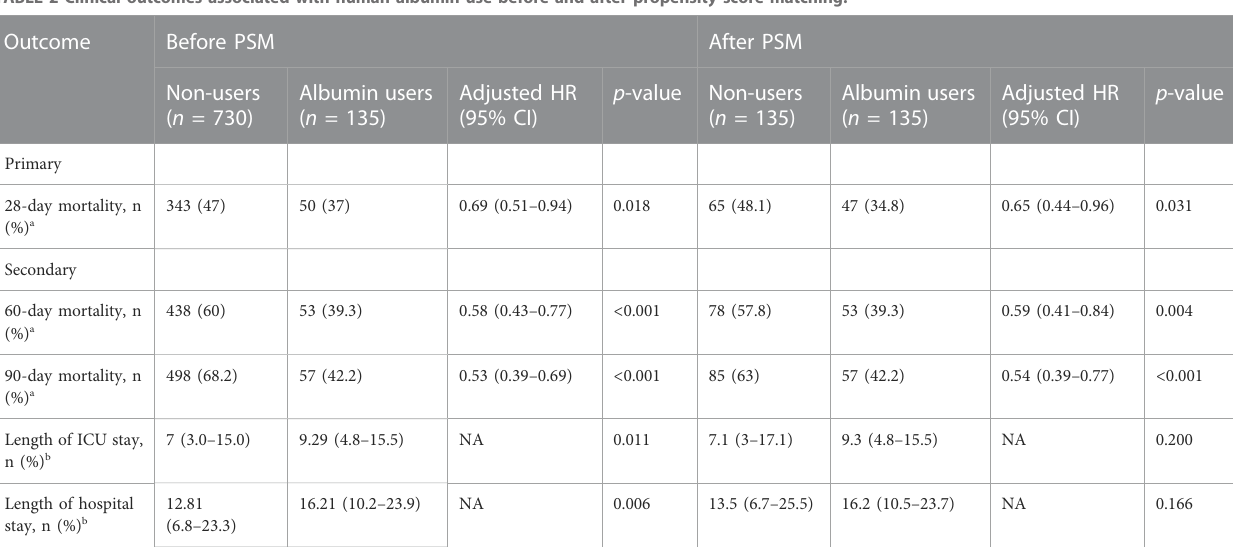
TABLE 2 Clinical outcomes associated with human albumin use before and after propensity score